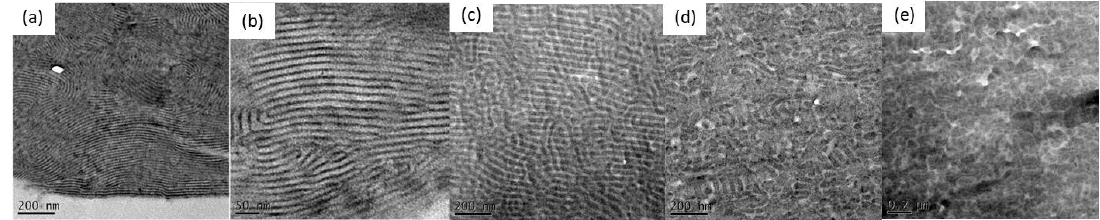
Figure 8. TEM images of PS- b -PVBA/PVBT blends, after thermal annealing at 180 °C, at compositions of ( a ) 100/0; ( b ) 90/10; ( c ) 70/30; ( d ) 50/50 and ( e ) 30/70.